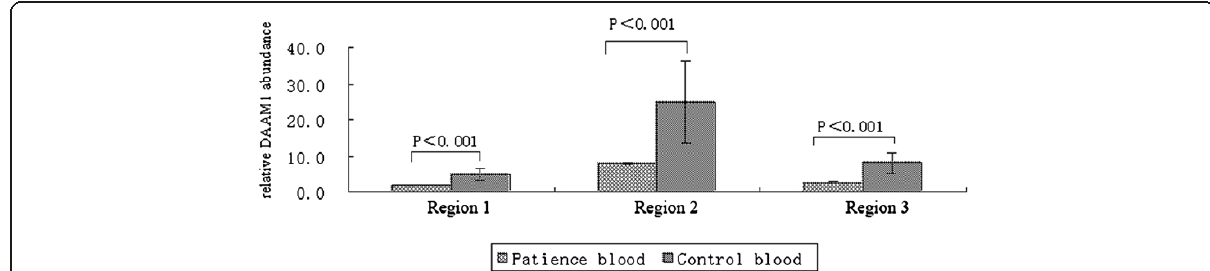
Figure 2 Comparison of DAAM1 abundance between the CHD fetal blood and the control blood. DAAM1 was significantly reduced in the three targeted genomic regions (P<0.001). Error bars showed the standard deviation (n ≥